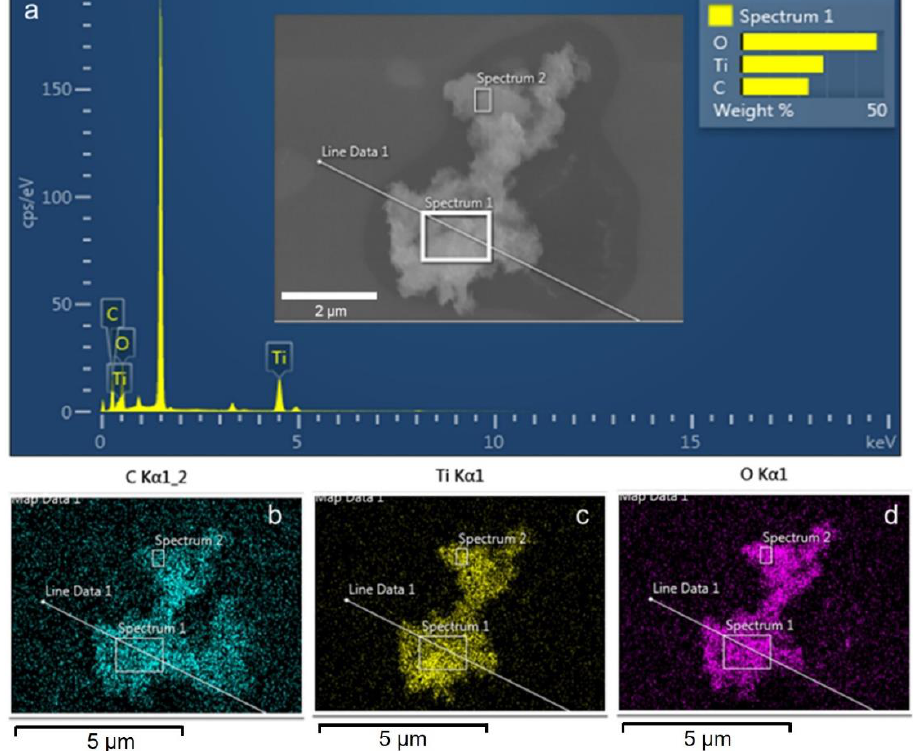
Figure 3. ( a ) EDX spectra of hybrid TiO 2 /CDs after CDs incorporation. Inset: SEM image of hybrid TiO 2 /CDs. ( b – d ) EDS mapping profiles of the rectangular area in panel ( a ) for ( b ) carbon, ( c ) titanium and ( d ) oxygen.